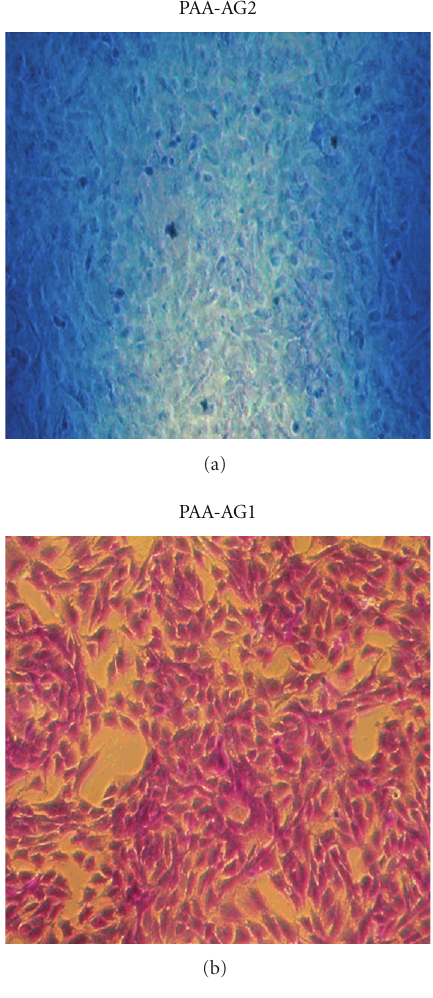
Figure 4: Morphology of mouse embryo fibroblasts grown on PAA- AG2 and PAA-AG1 after 10 days of culture [42].